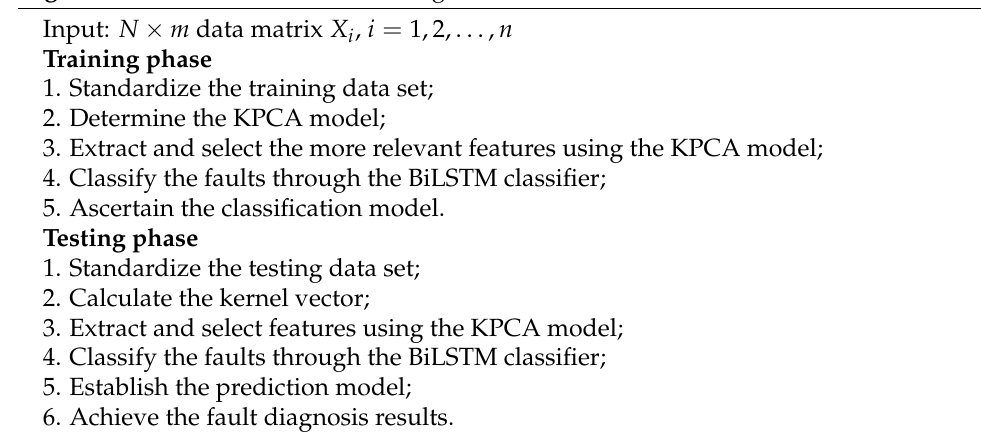
Figure 4. Architecture of the proposed approach. Algorithm 1 KPCA-based BiLSTM